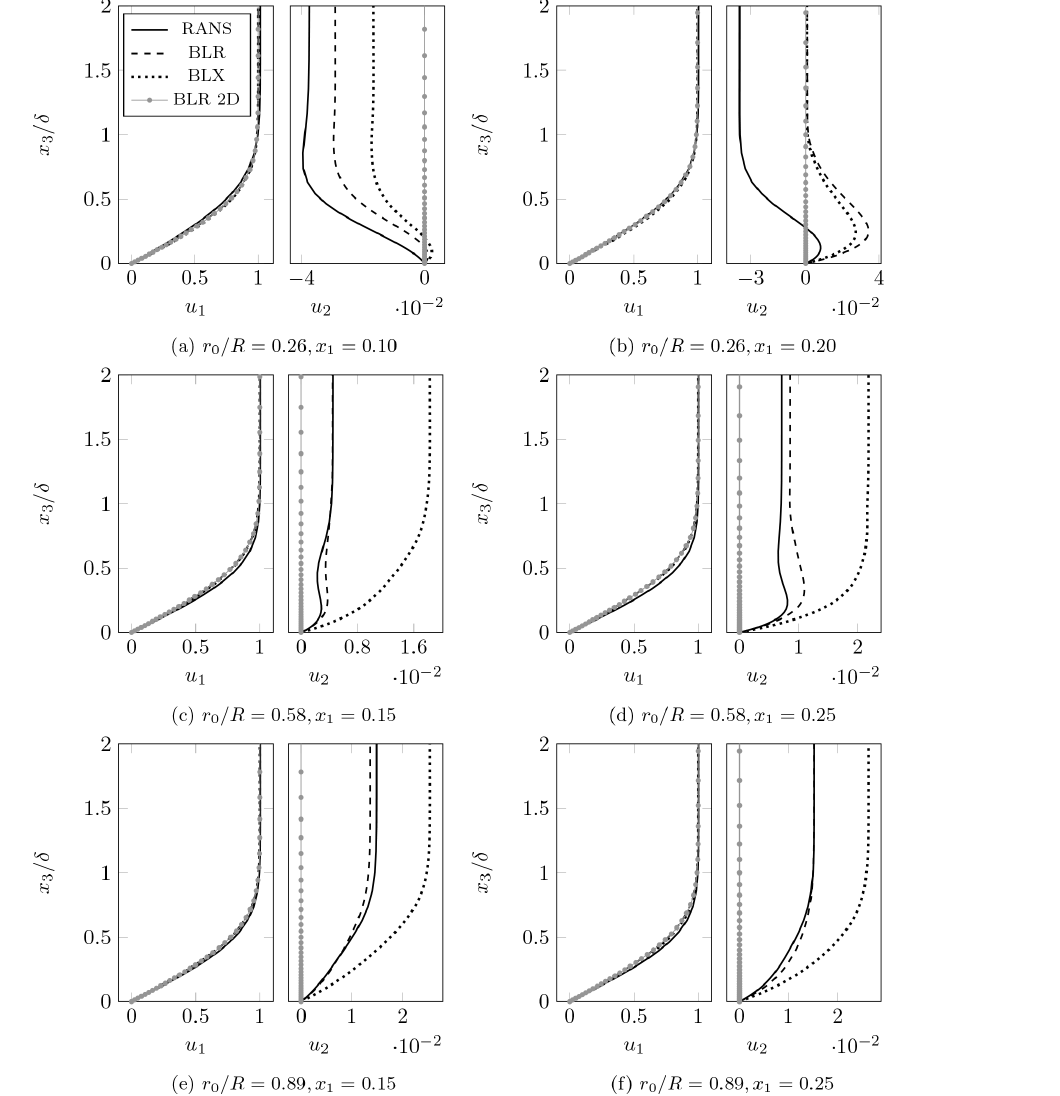
Figure 6. Boundary-layer profiles for Geometry